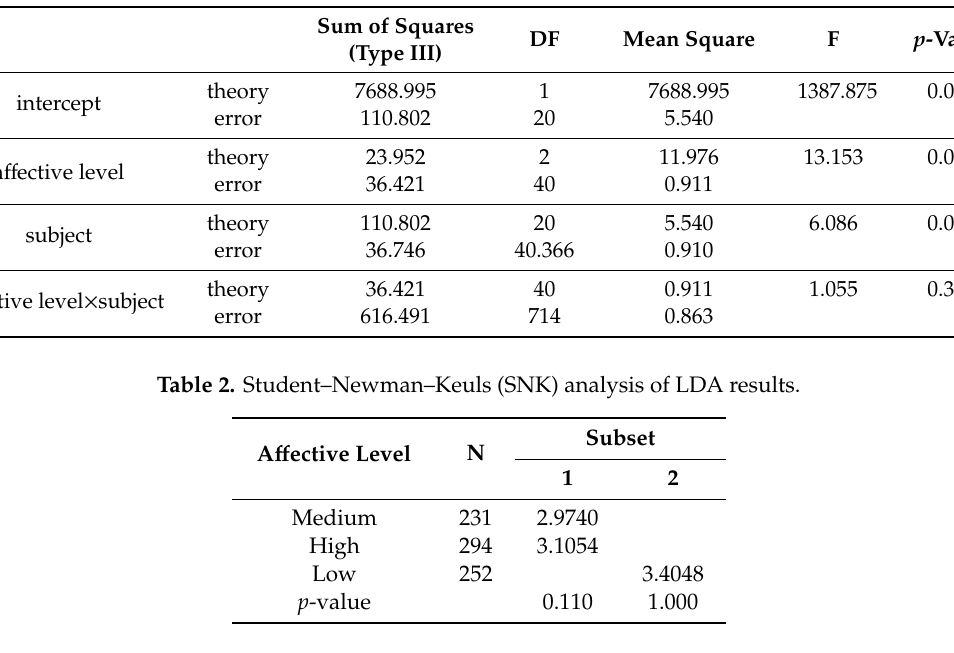
Table 1. Analysis of variance (ANOVA) results corresponding to the application of Latent Dirichlet Allocation (LDA).